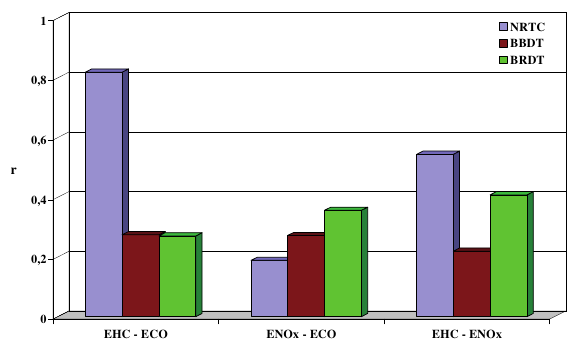
Fig. 21. The coefficient of Pearson’s linear correlation – r between the pollutant emission intensity in individual